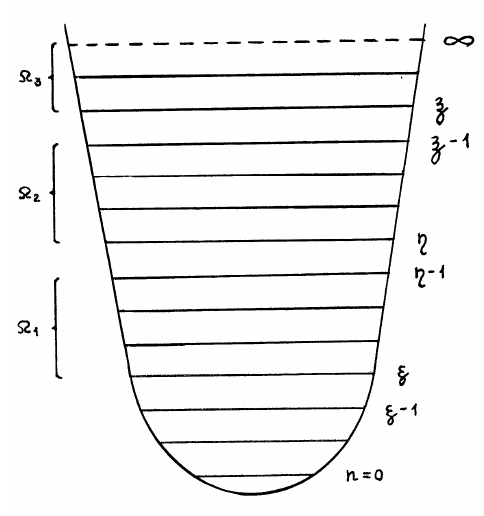
Figure 2. Partition of the energy levels of the averaged quantum oscillator taking into account of the degree of degeneracy ( ξ < η < ζ